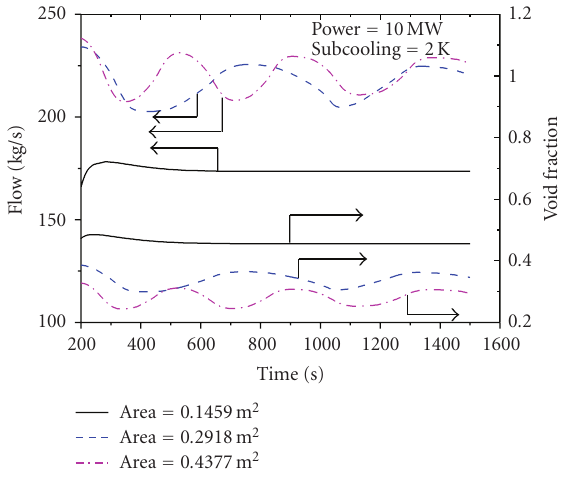
Figure 19: E ff ect of an increase in riser area on stability.